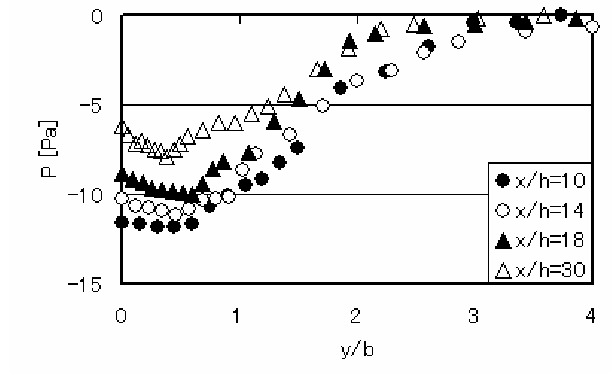
Fig. 14 Mean pressure distributions ( Re =3.0×10 4 ).